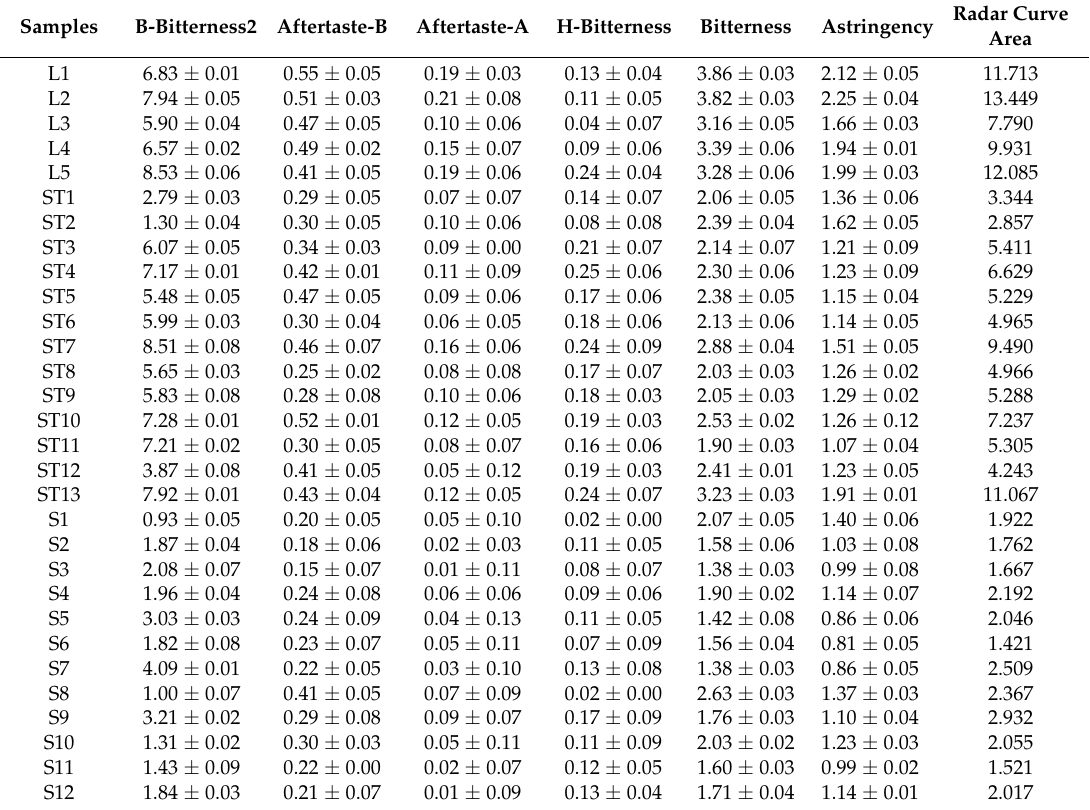
Table 1. Taste intensities of each taste factor in all AH samples (mean ± RSD, n = 3) and the Radar curve